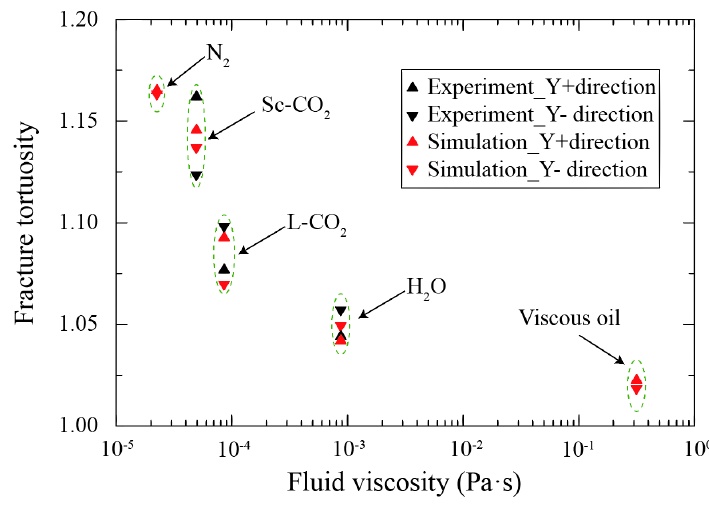
Figure 13. Summary of fracture tortuosity from experimental observations and simulation results.